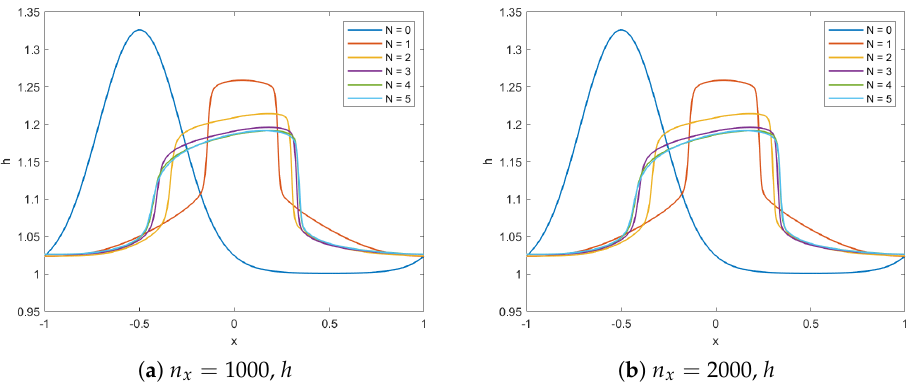
Figure 19. Smooth periodic wave test case water height using PFE scheme for different N and two different n x = 1000 ( b ) and n x = 2000 ( a ) for constant λ = 10 − 4 shows that the solution is